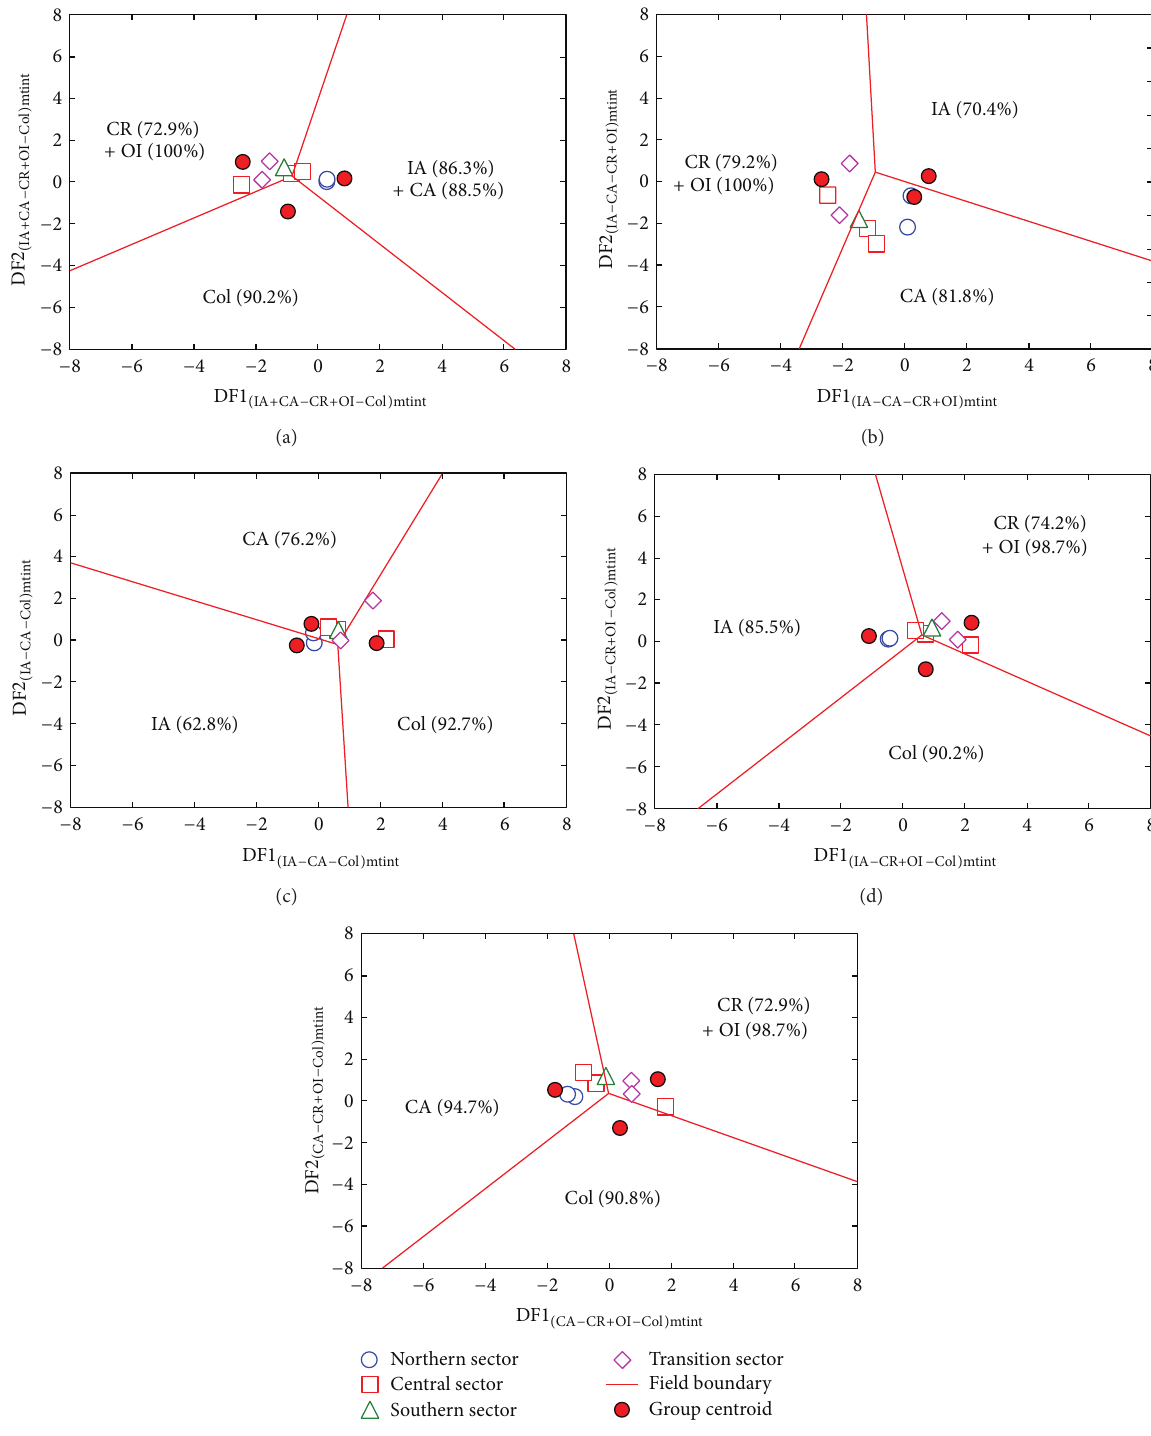
Figure 4: Discriminant-function multidimensional diagrams based on ln-transformed ratios of immobile major and trace elements for tectonic discrimination of intermediate Sierra de las Cruces magmas. The symbols are explained as inset in (a); more details are in Figure 3. The subscript “mtint” in axis names refers to major (m) and trace (t) element ratios for intermediate (int)